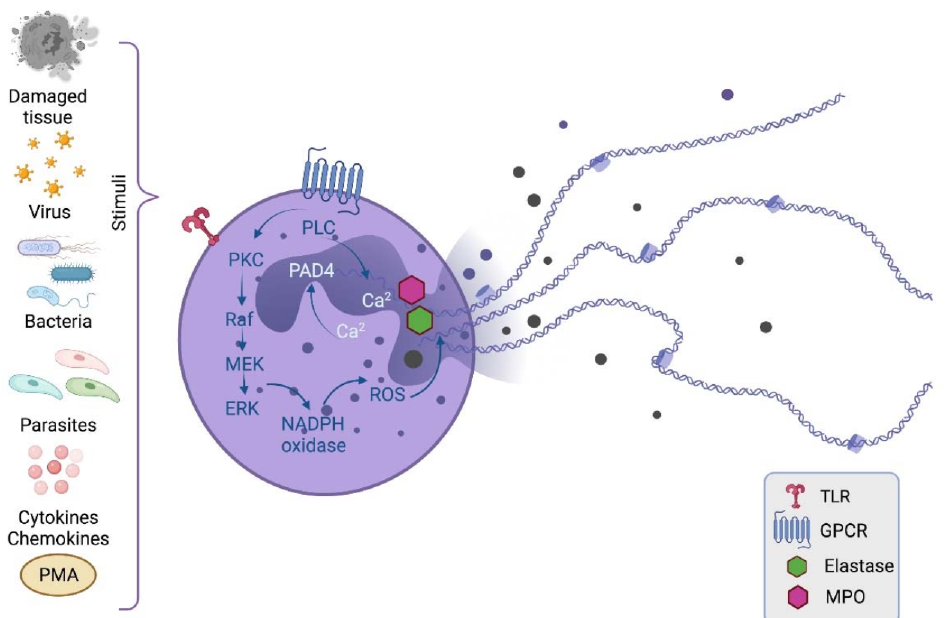
Figure 1. Mechanism of NET generation. NET formation begins with neutrophil activation through the recognition of chemical or biological stimuli, followed by the activation of intracellular enzymes, such as PKC. PKC phosphorylates the Raf-MEK-ERK pathway, where ERK phosphorylates the NADPH oxidase complex, leading to ROS generation. ROS promote the translocation of elastase and MPO to the nucleus where together with PAD4 they lead to chromatin decondensation. Finally, the DNA associated with antimicrobial peptides from the cytosolic granules is released to the extracellular space. PMA, phorbol 12-myristate 13-acetate; PKC, protein kinase C; PLC, phospholipase C; PAD4, peptidyl arginine deiminase-4; ROS, reactive oxygen species; TLR, Toll-like receptor; GPCR, G- protein-coupled receptors; MPO, myeloperoxidase. Created with